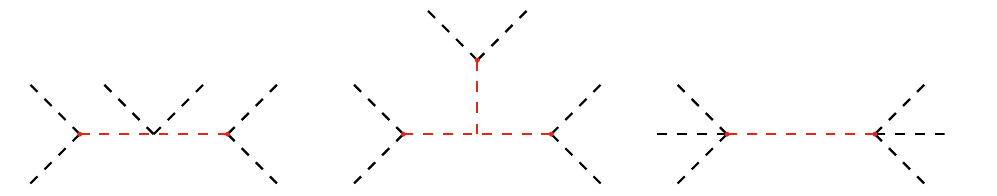
Fig. 5 Tree-level generation of the | H | 6 operator (external lines, black) obtained by integrating out new scalar degrees of freedom (internal propagators, red)